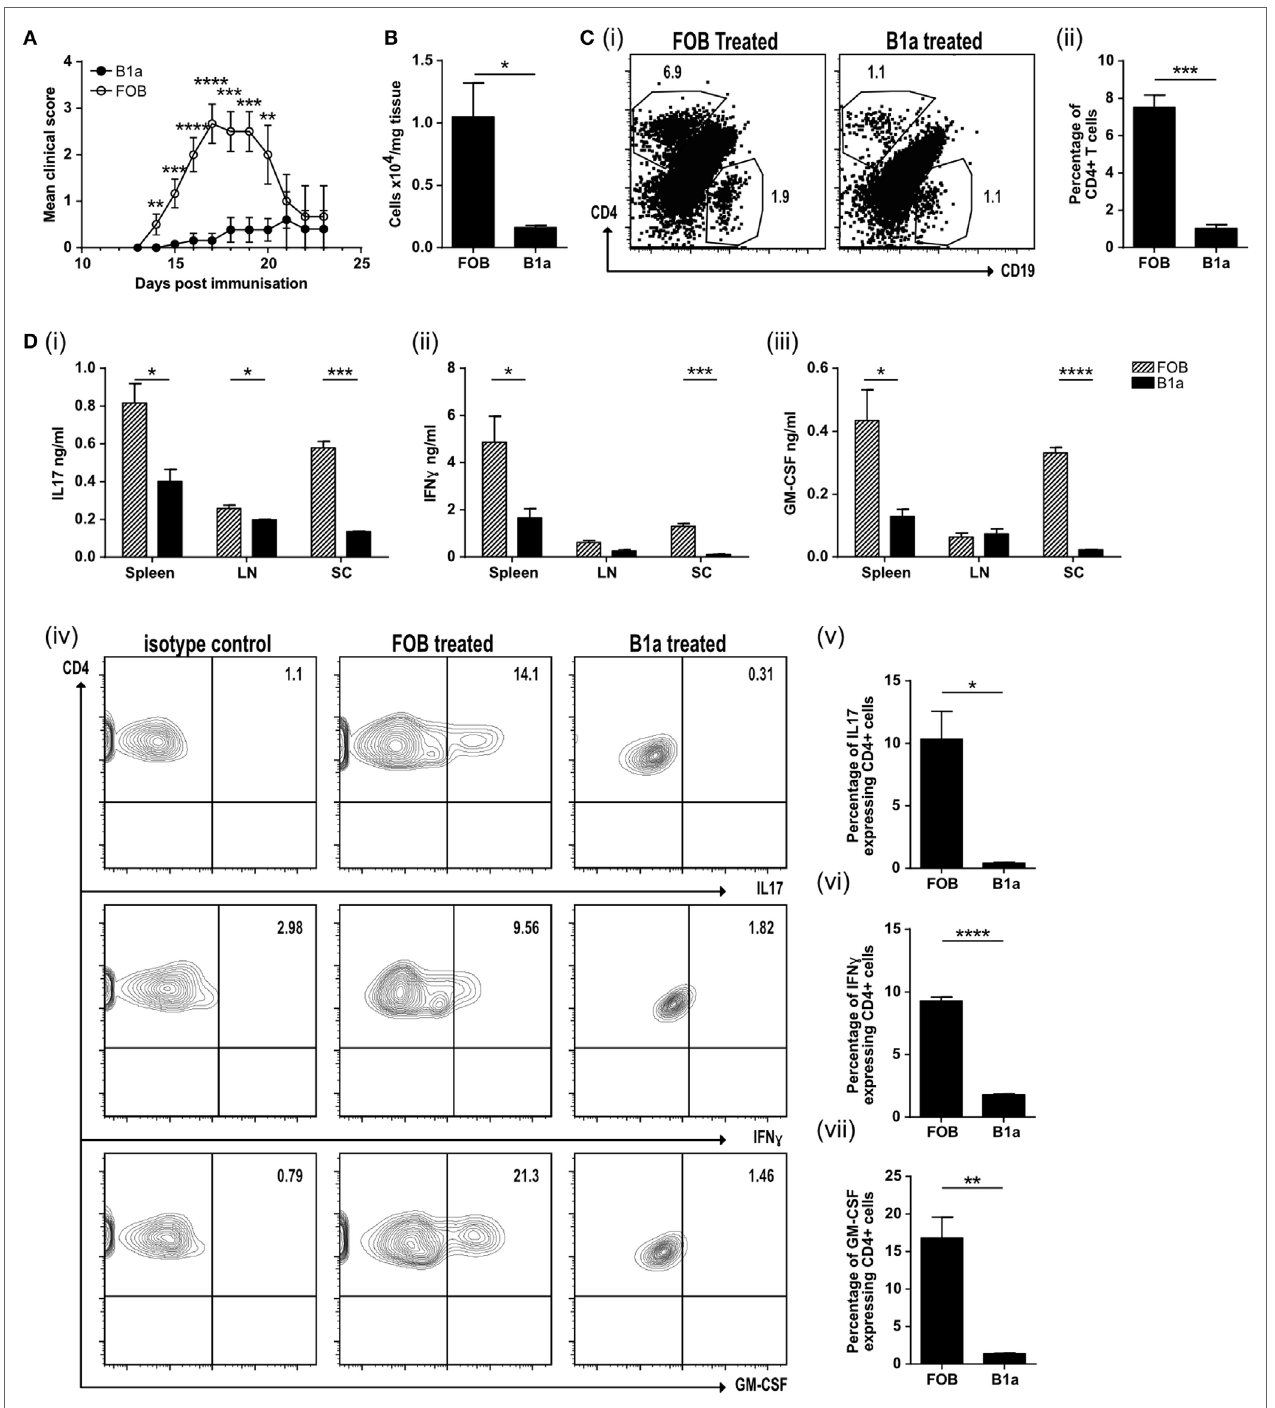
FigUre 5 | B1a cells protect mice from experimental autoimmune encephalomyelitis (EAE) by reducing cell inflammatory cell influx into the spinal cord. (a) Mean clinical score of mice treated with either splenic follicular B (FOB) cells (CD19 + ve CD23 + ve CD21 lo CD43 − ve ) (open circles) or peritoneal cavity B1a cells (CD19 + ve CD43 + ve CD5 + ve ) (filled circles) that had been treated with the TLR7/8 ligand R848 for 48 h in vitro . Data representative of six individual mice. (B) Number of cells per mg of spinal cord tissue. (c) CD4 + ve T cells and CD19 + ve B cells within the spinal cord. Representative plots can be found in (i) and pooled data from three individual mice graphed (ii). (D) Cells were restimulated with 20 μ g/ml MOG for 72 h before measuring, (i) IL-17, (ii) IFN- γ , and (iii) GM-CSF in the supernatants. Data from FOB-treated mice is shown with patterned bars, and B1a-treated mice shown with solid bars. Cultures were also IC stained for cytokines. Representative plots from spinal cord CD4 + ve cells are shown in (iv) and data pooled from three individual mice graphed for IL-17 (v), IFN- γ (vi), and GMCSF (vii). Statistical differences were determine by unpaired Student’s t -test * P < 0.05, ** P < 0.01, and *** P < 0.001.